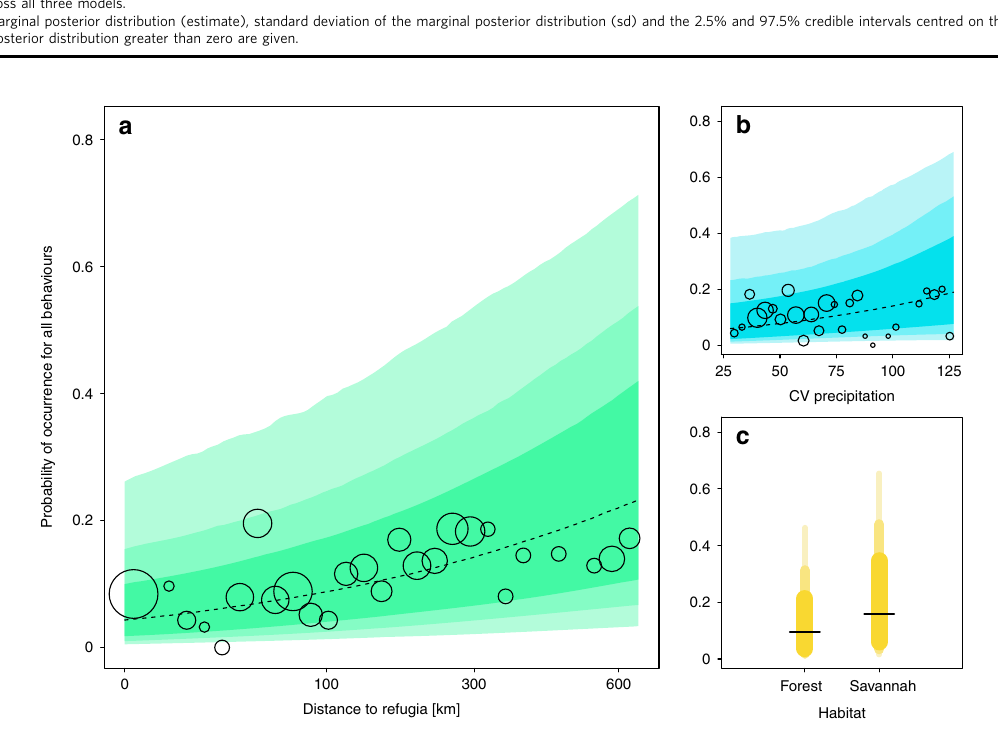
Fig. 2 The probability of occurrence for 31 chimpanzee behaviours per community as a function of environmental variability. These behaviours are more likely to occur when chimpanzees live in habitats a further away from Pleistocene forest refugia, with b greater precipitation seasonality, and c a predominantly savannah woodland landscape. The size of the circles in plots a and b indicates the sample size, or number of chimpanzee communities per value of the predictor where the total n = 144 chimpanzee communities. The coloured areas depict the 67, 87, and 97% credible intervals centred on the mean predicted posterior distribution ( a , b dashed line, c horizontal line) for the probability of occurrence across all 31 behaviours.